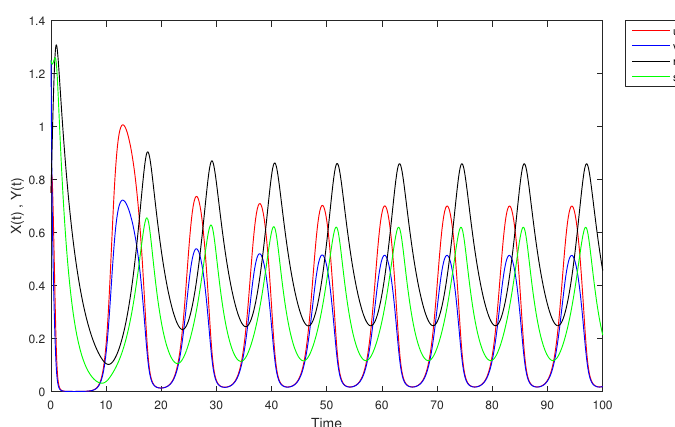
Figure 30. The solution of (13) at α = 0.5 as time increases. At α -level = 1, the solution is shown in Figure